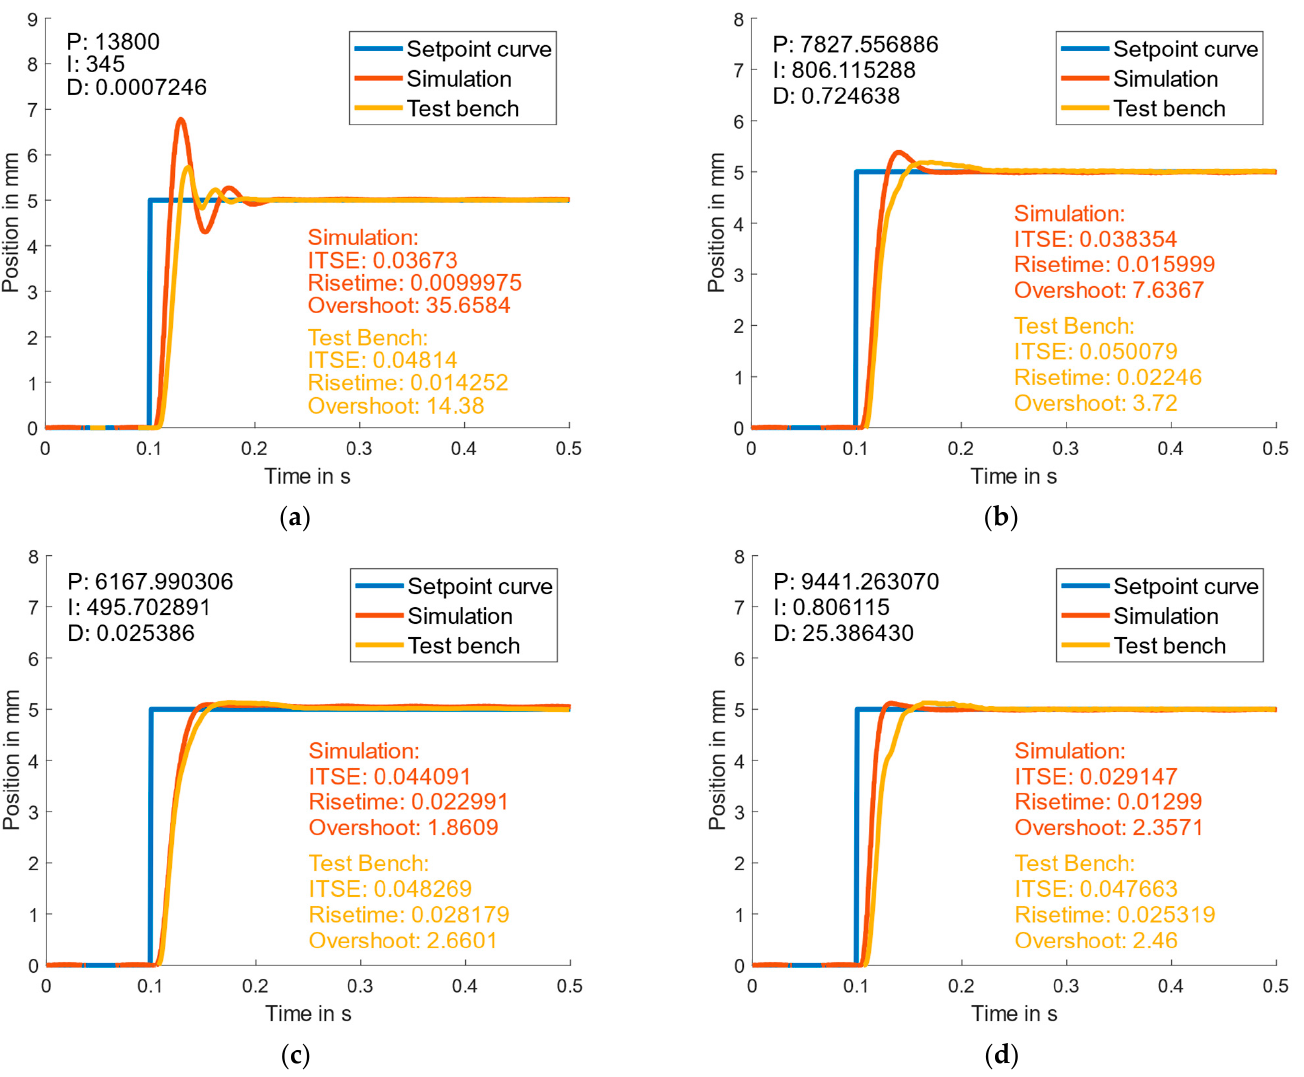
Figure 7. Comparison of the simulated and on the test bench measured step response of the EHA with the following PID parameters obtained with the method for multi-objective optimization of PID control for the inertial load: ( a ) Ziegler Nichols characterization [ 𝐾 (cid:3017) = 13,800; 𝐾 (cid:3010) = 345; 𝐾 (cid:3010) = 0.0007246], ( b ) system characterization [ 𝐾 (cid:3017) = 7827.556886; 𝐾 (cid:3010) = 806.115288; 𝐾 (cid:3010) = 0.724638], ( c ) first optimization loop [ 𝐾 (cid:3017) = 9441.263070; 𝐾 (cid:3010) = 0.806115; 𝐾 (cid:3010) = 25.386430], and ( d ) second optimization loop [ 𝐾 (cid:3017) = 6167.990306; 𝐾 (cid:3010) = 495.702891; 𝐾 (cid:3010) = 0.025386].